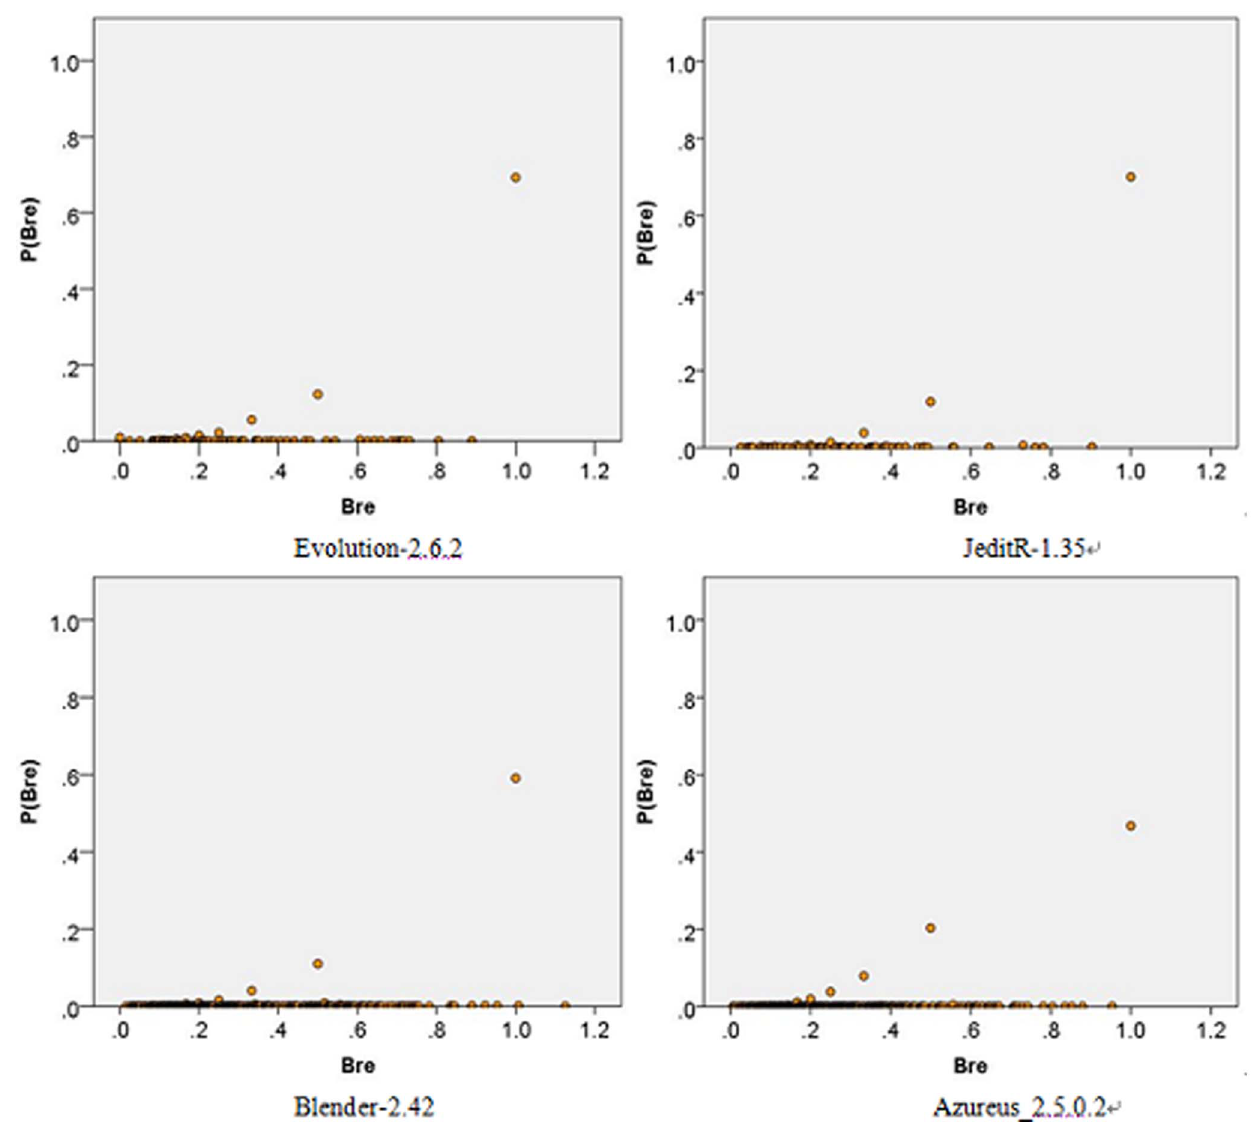
N represent P ( Bre ). The distribution can be plotted with two branches, one of